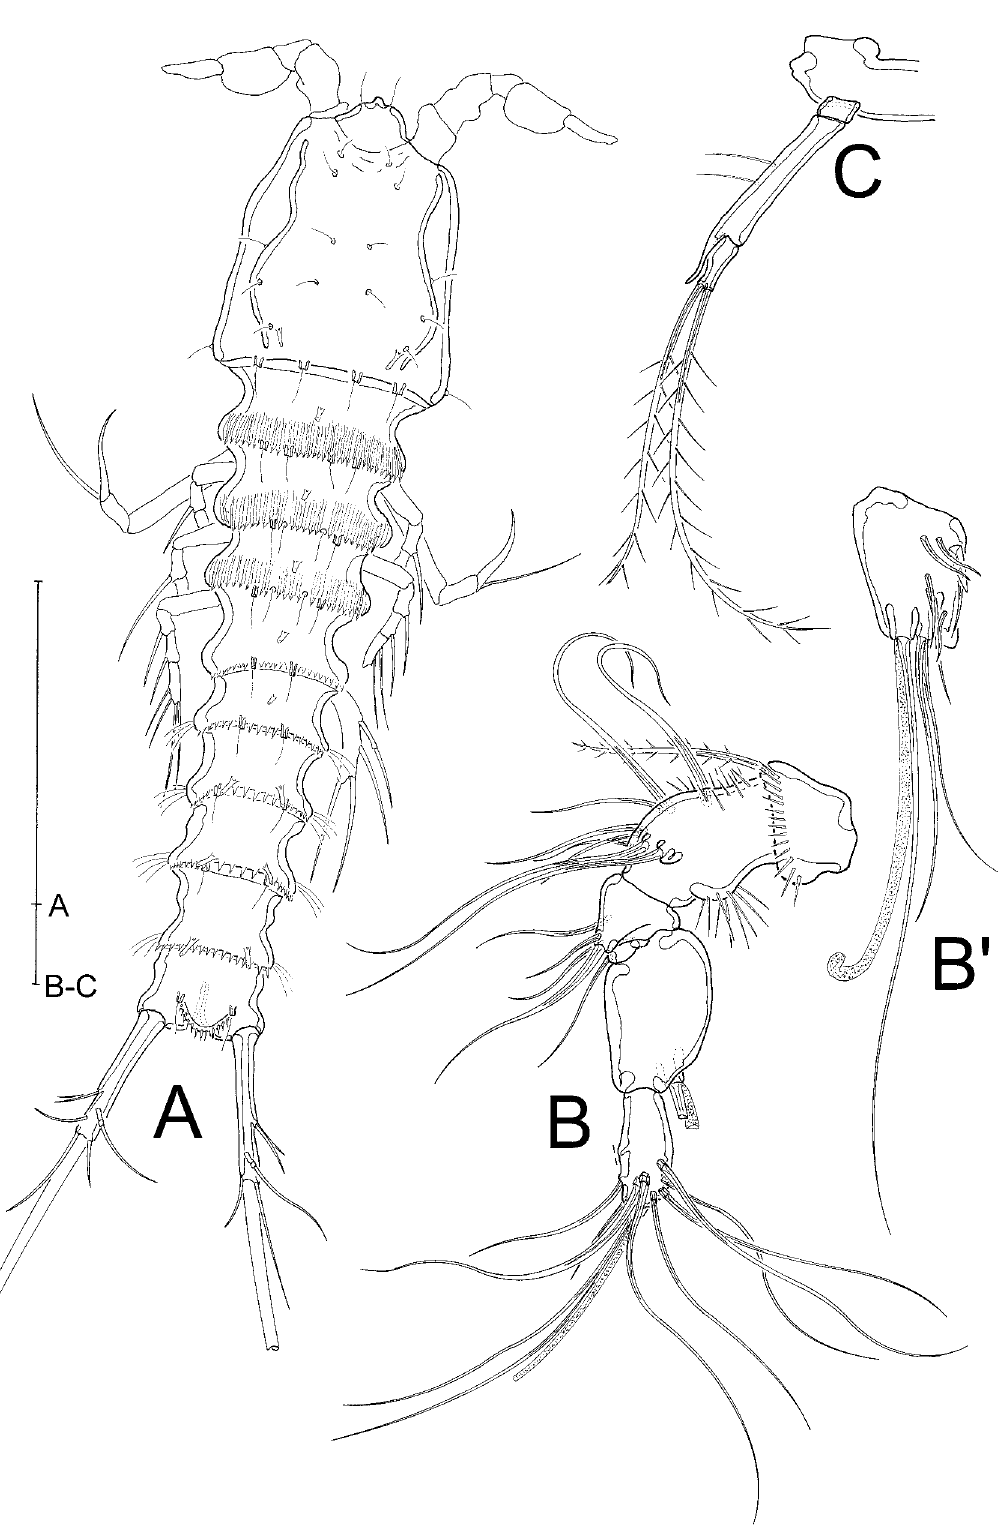
Fig. 6. Laophontodes typicus T. Scott, 1894, ♂ (A: BMNH 2015.1144–1153-2; B–C: BMNH 2015.1144– 1153-4). A . Habitus, dorsal view. B . A1. B’ . Fifth segment of A1 showing setation. C . P3 enp. Scale bar: A = 100 µm, B–C = 50